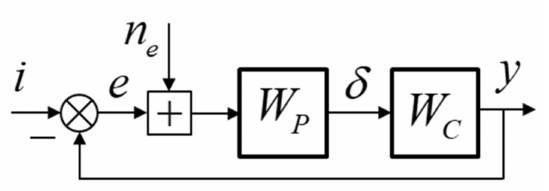
Figure 5. Pilot–aircraft